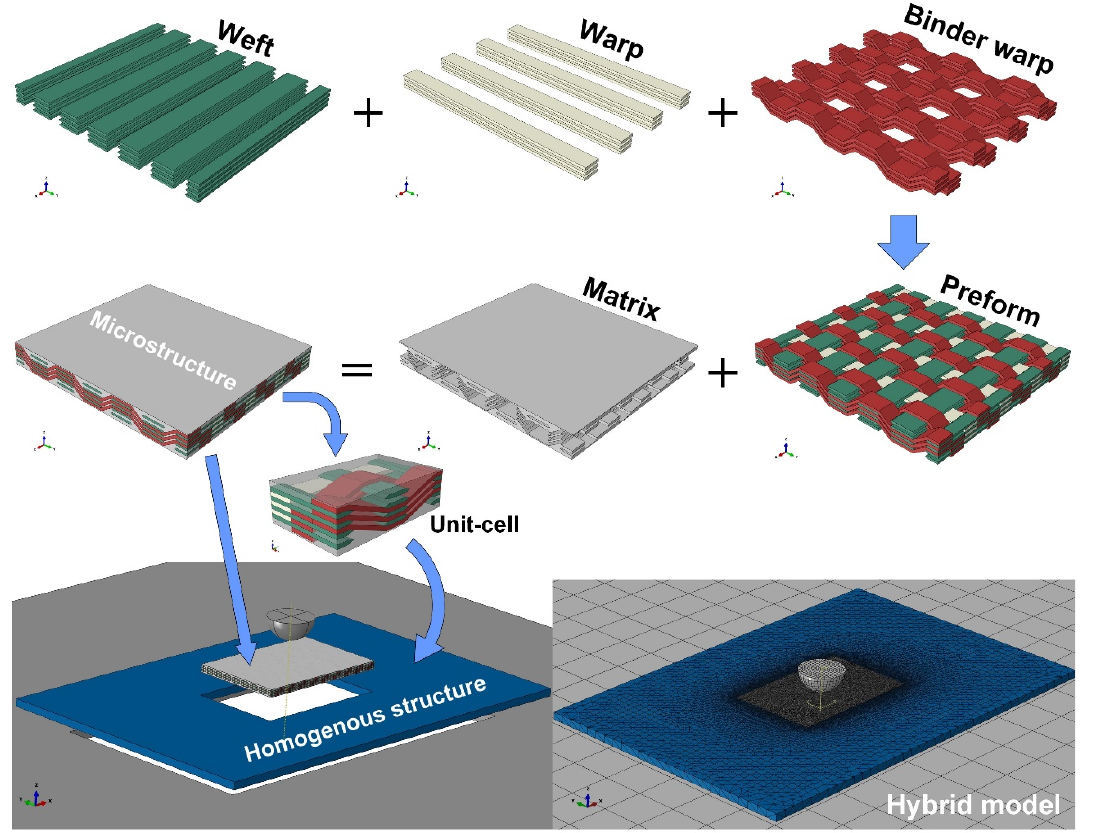
Figure 1. Hybrid finite element analysis model.